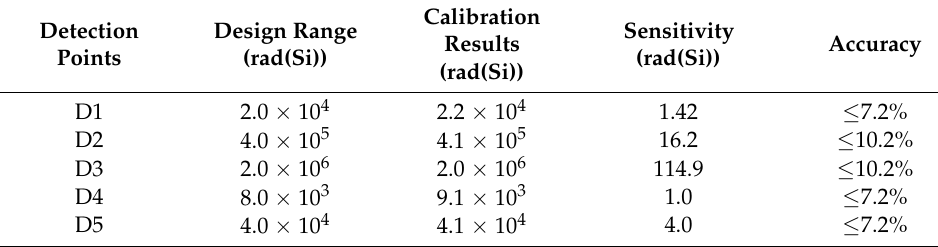
Table 4. Calibration results of the dose